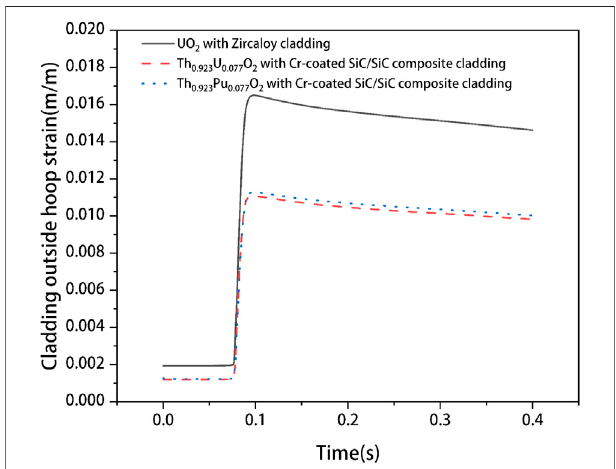
FIGURE 22 | Hoop strain evolutions for the cladding of the UO 2 fuel, the cladding of the Th 0.923 Pu 0.077 O 2 fuel, and Th 0.923 U 0.077 O 2 fuel under the RIA